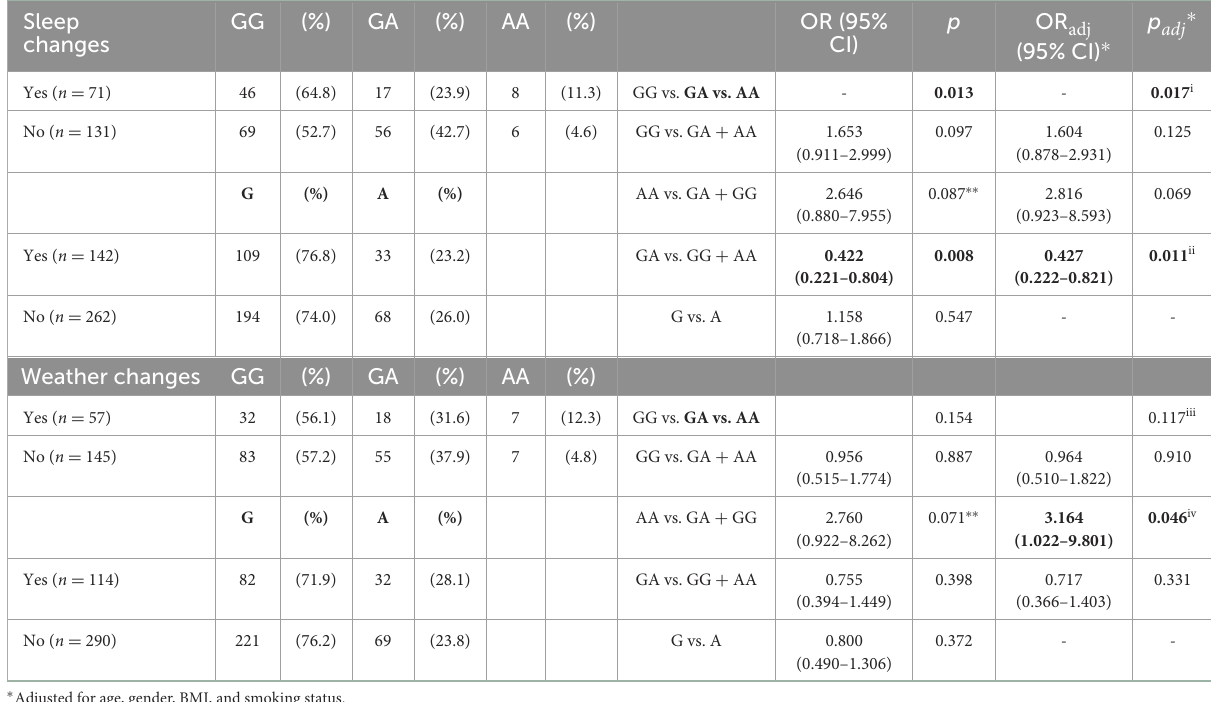
TABLE 8 Association analysis of the CAT rs1001179 variant with migraine triggers. Sleep changes